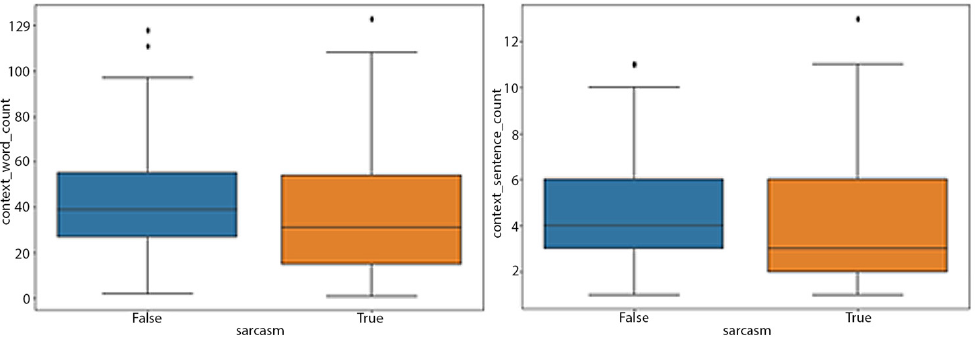
Figure 2. Words ( left ) and sentence ( right ) boxplot, grouped by sarcasm. Dots represent outlier values.